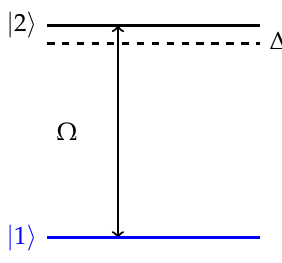
Figure 1. Two-level